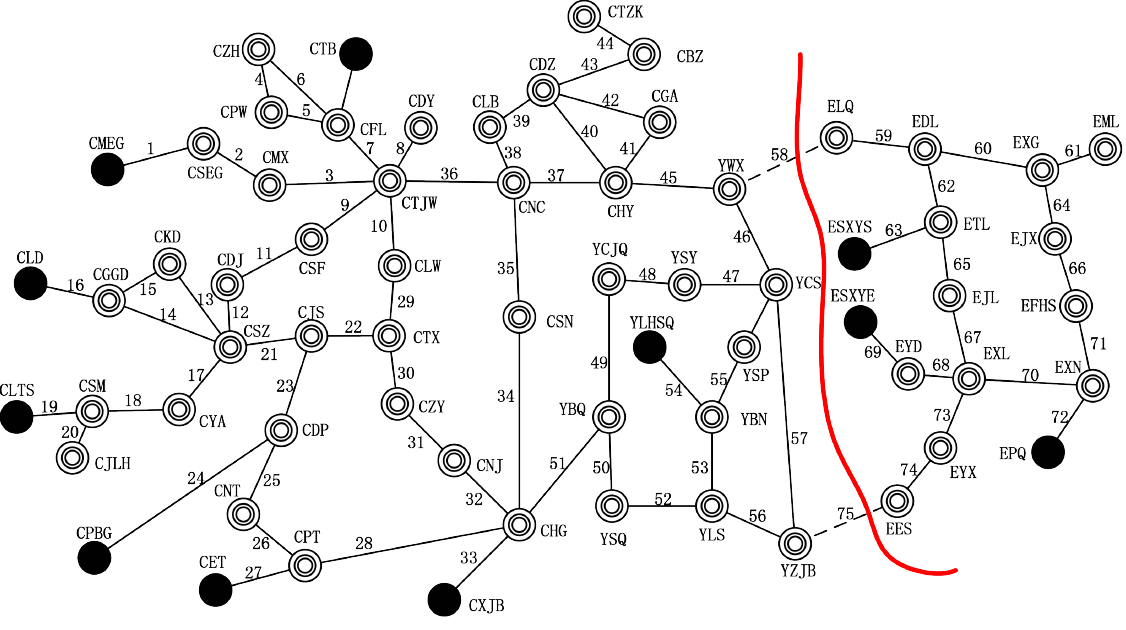
Figure 22. The islanding solution for the reduced power system of Central China.